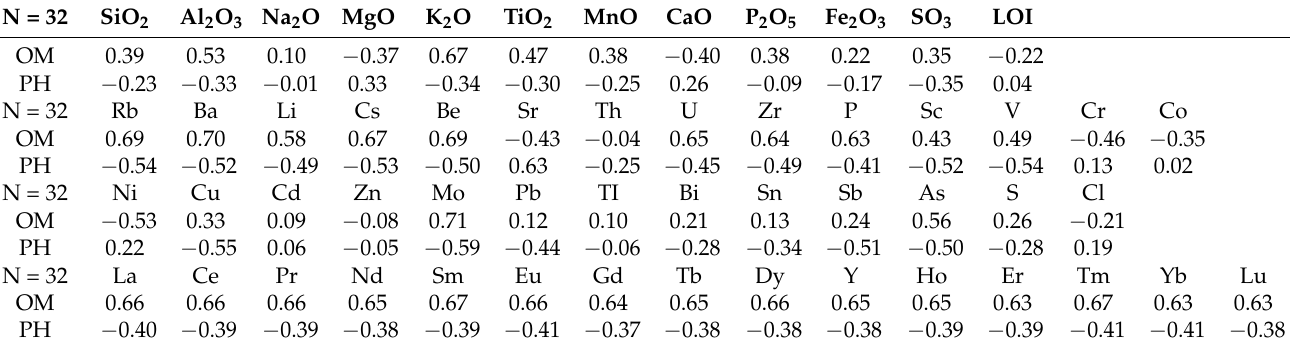
Table 7. Pearson’s correlation coefficients between major oxides, trace and rare earth elements and organic matter (OM) and pH in studied soil samples (N = number of